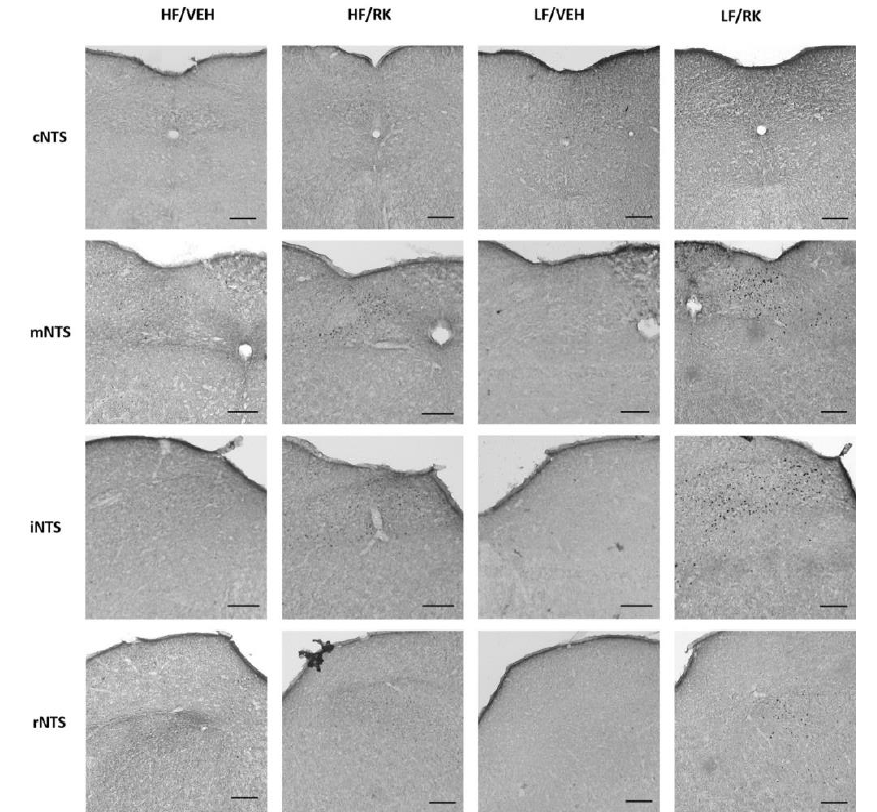
Figure 7. Representative coronal micrographs from NTS and AP in mice dosed with vehicle or raspberry ketone (400 mg / kg). Immunopositive c-Fos cells are stained black. NTS subareas are caudal (cNTS; − 7.92 mm from Bregma); medial (mNTS; − 7.48 mm from Bregma); intermediate (iNTS; − 7.08 mm from Bregma); rostral (rNTS; − 6.84 mm from Bregma). AP are located mNTS. Black bar in each image represents 153 µm.